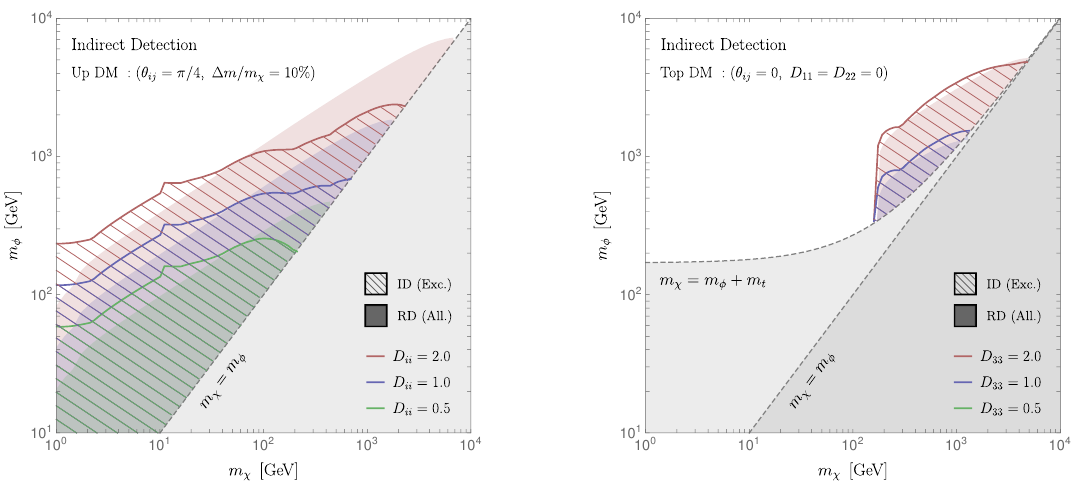
Figure 9 . The ID constraints on DMFV model, with ‘maximal’ mixing (cid:18) for couplings to top quarks only (right), assuming degenerate DM masses. Bounds are produced on individual (cid:12)nal states, and therefore scale with the dominant annihilation channel, somewhat surprisingly the top quark channel gives stronger constraints due to the extremely sensitive (cid:13) -ray search by H.E.S.S